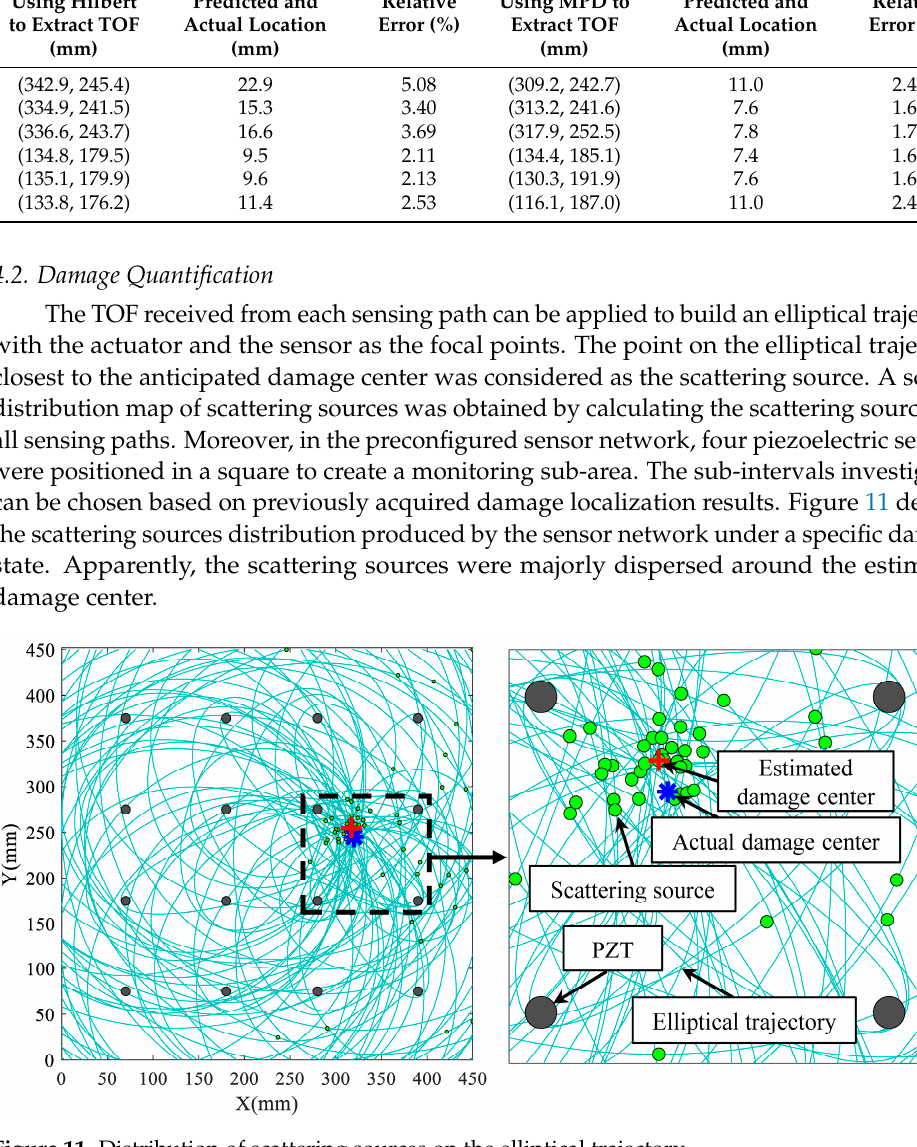
Table 2. Damage center prediction results and errors.